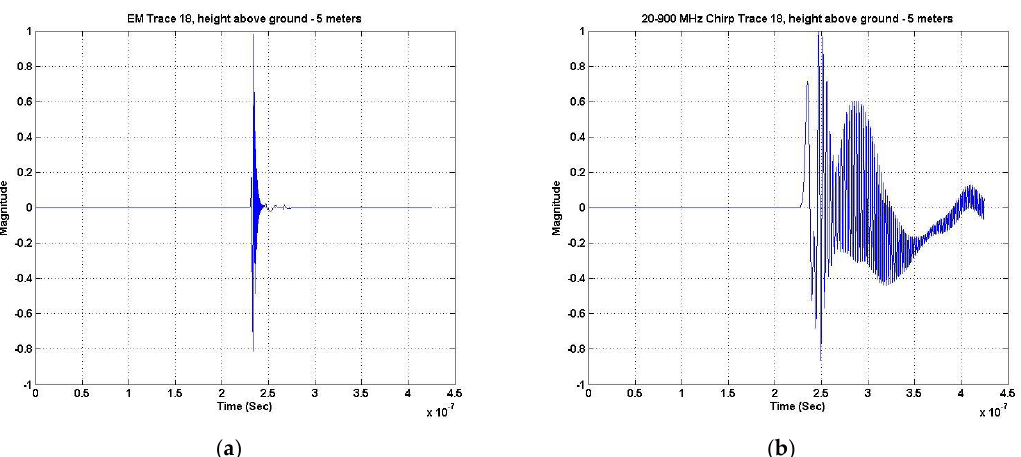
Figure 5. ( a ) Trace 18 of 36 traces total, roughly 5 m out of 10 m total distance in x direction, a 1-D plot of EM Gaussian mixture model (GMM) analysis. ( b ) Trace 18 of 36 traces total, roughly 5 m out of 10 m total distance in x direction, a 1-D plot of chirp excitation analysis.